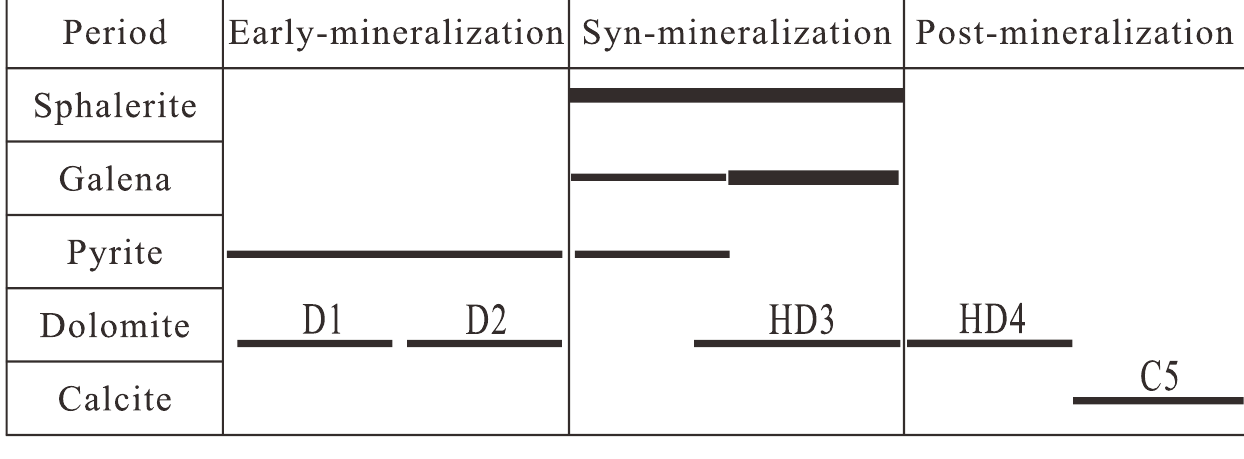
Figure 4. Mineral paragenesis in the Fuli Pb-Zn deposit.